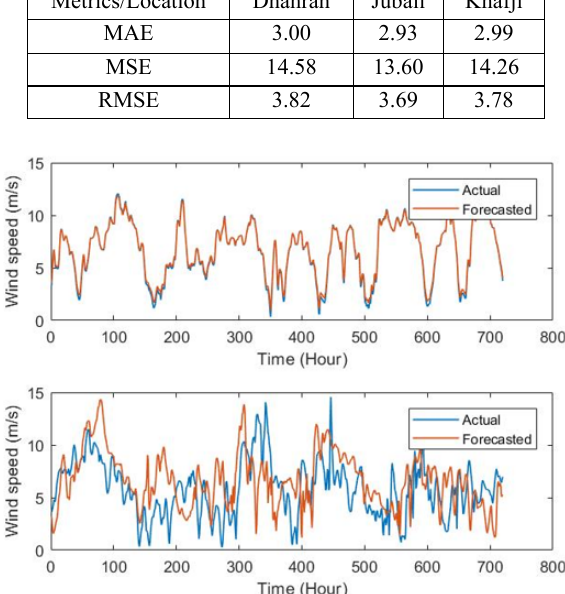
Figure 14. Forecasted and actual wind speeds of 2017, Jan & Feb, Dhahran Case II.